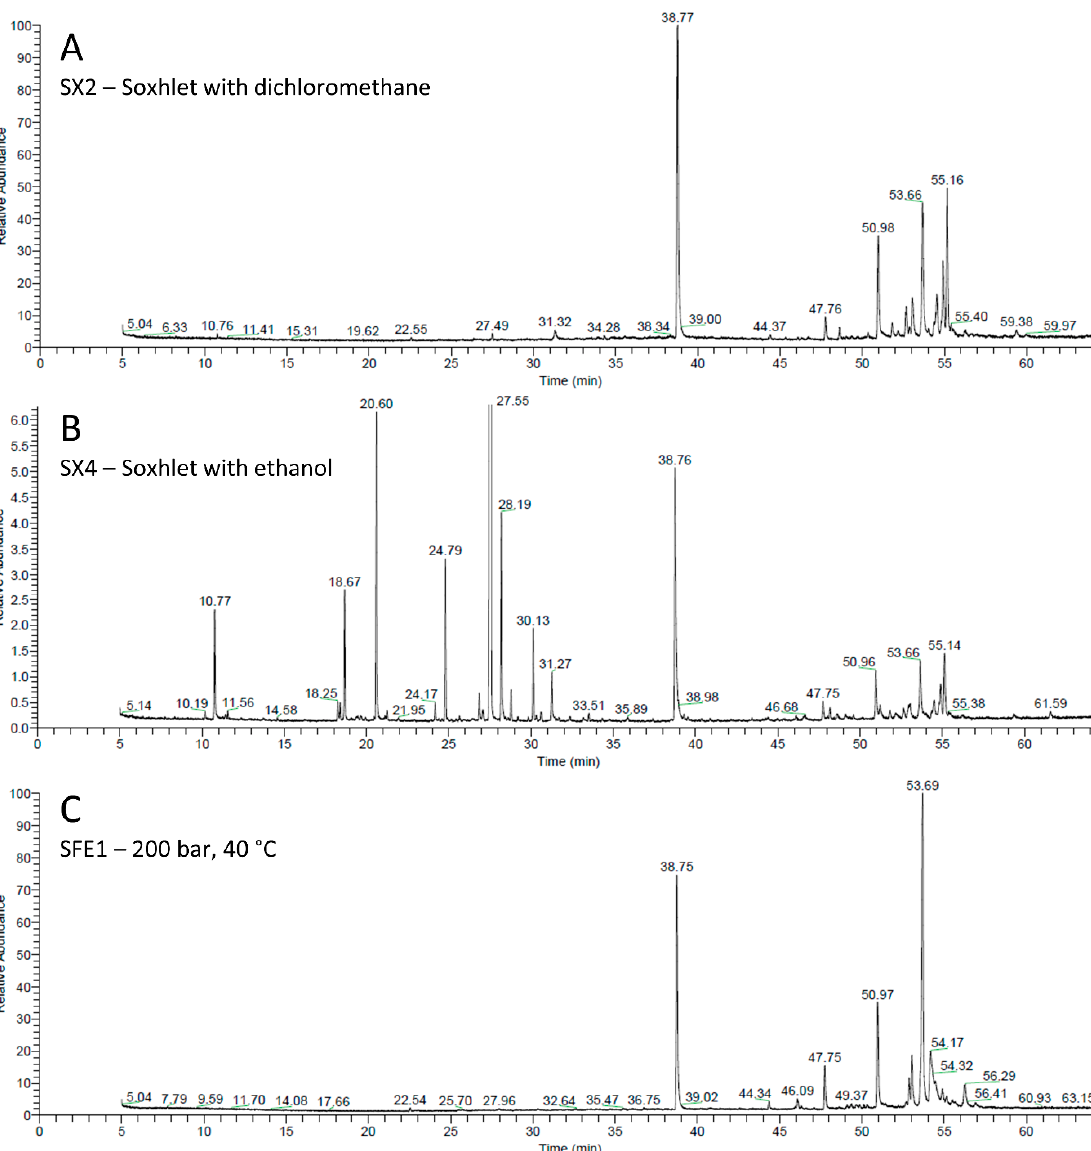
Figure 4. Chromatograms of the extracts from runs ( A ) SX2 (dichloromethane), ( B ) SX4 (ethanol) and ( C ) SFE1 (200, bar 40 °C). Internal standard (tetracosane) appears at 38.7 min. Table 2. List of identified compounds and respective retention times and reverse match factors (RSI) for all Soxhlet and SFE runs.